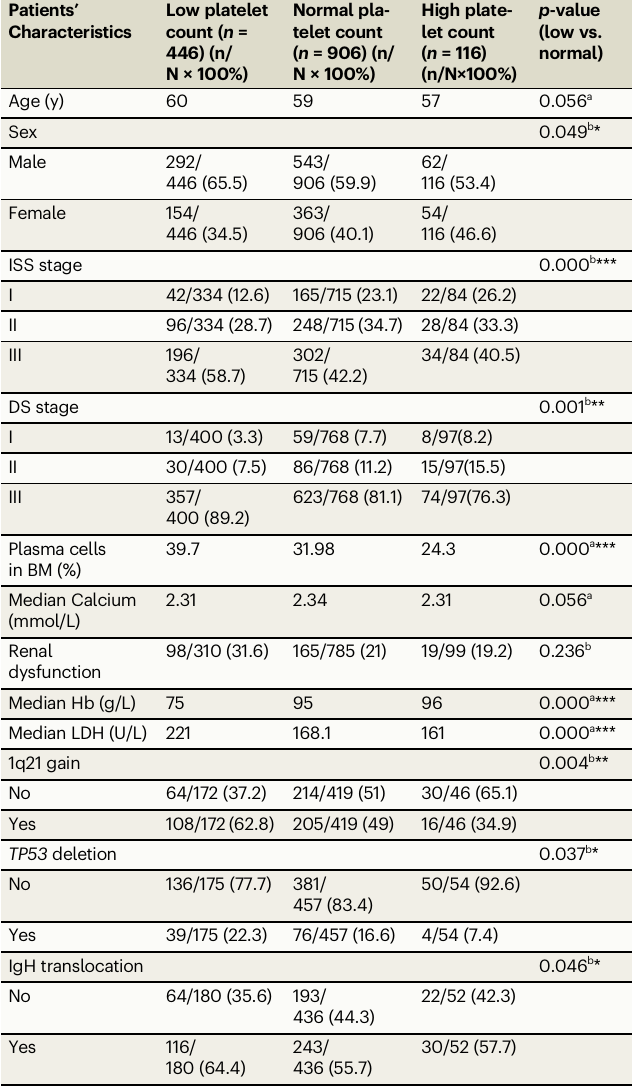
DSstage Durie-Salmonstage, ISS International StagingSystem, FISH fl uorescence insitu hybridization, LDH lactatedehydrogenase, y years. Hb hemoglobin, Renal dysfunction: Creati- ninelevel> 2.0mg/dL; 1q21 gain:FISH1q21 gainin ≥ 10% ofcells; TP53 deletion: FISH TP53 deletion in ≥ 10% of cells; FISH IgH translocationin ≥ 10% ofcells; OS overallsurvival, PFS progression-free survival; allMM patients were newly diagnosed. * p < 0.05, ** p < 0.01, *** p < 0.001. a Unpairedtwo-sided Student ’ s t -test. b Two-tailed Pearson Chi-Square